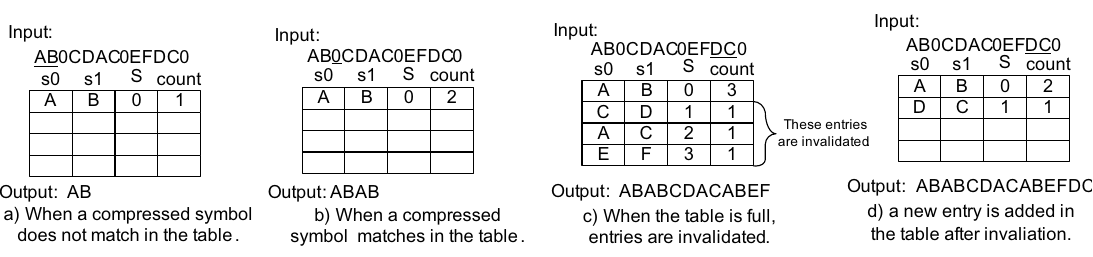
Figure 4. Decompression example of LCA-DLT.